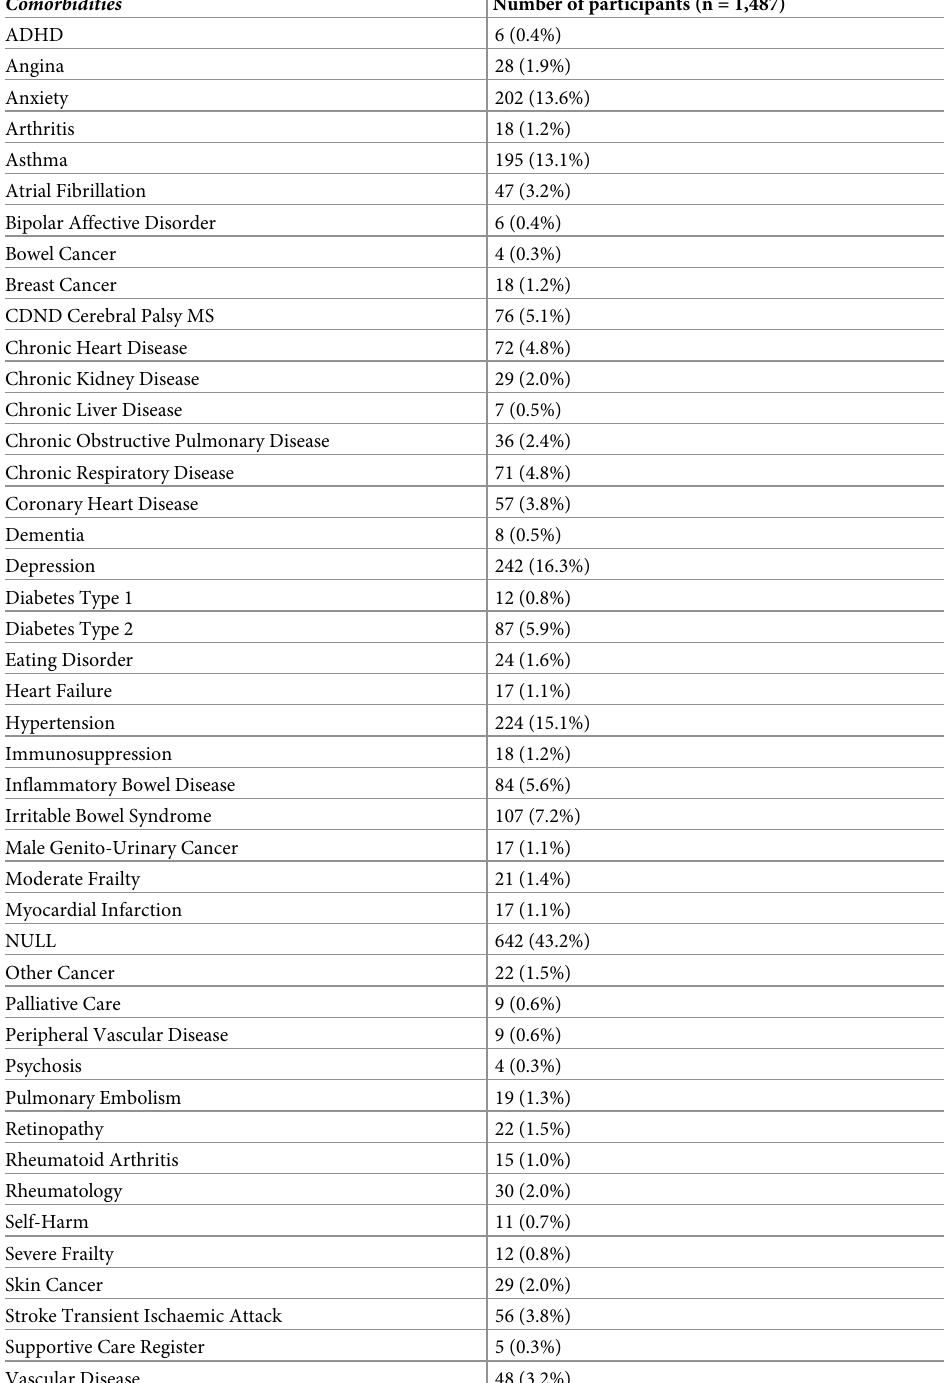
Table 1. Baseline